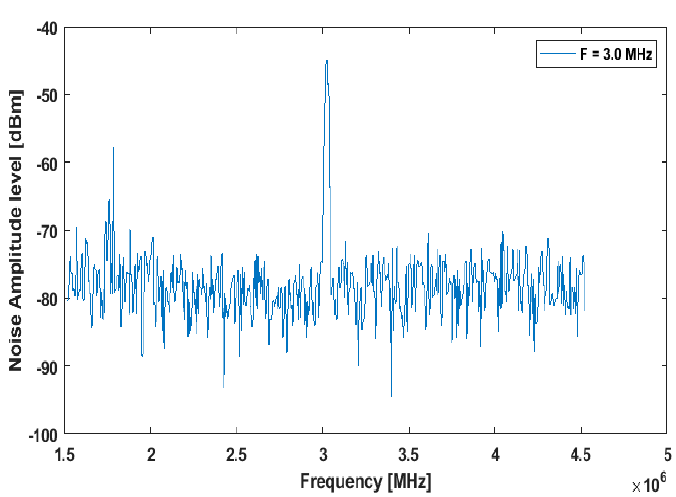
Figure 8. Electric Kettle observed noise power from 3 MHz to 30 MHz.